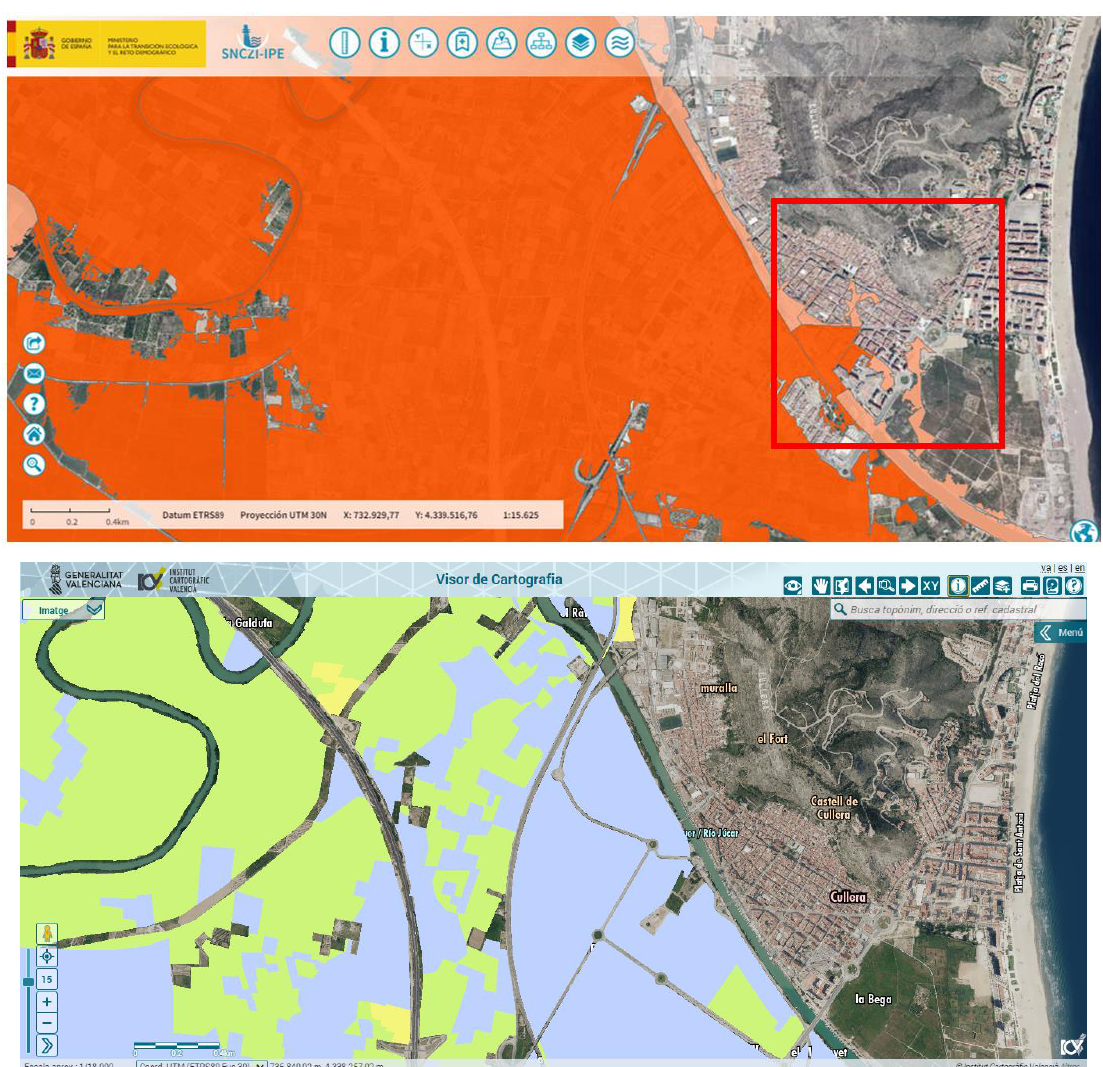
Figure 8. Local-scale. Image capture of the risk layers of the NFZMS (flood risk; return period 500 years) and the PATRICOVA viewer (city of Cullera; Júcar River). Note: the red box corresponds to where the main differences are located at the local scale. Source: Ministry for the Ecological Transition and Demographic Challenge [48]; Valencian Cartographic Institute [53]. Own elaboration.